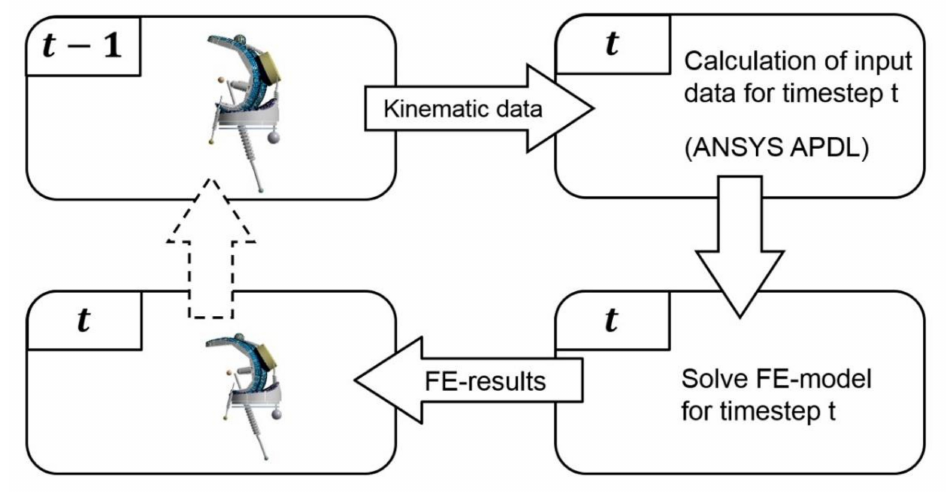
Figure 3. Iterative solving process using kinematic data from previous time